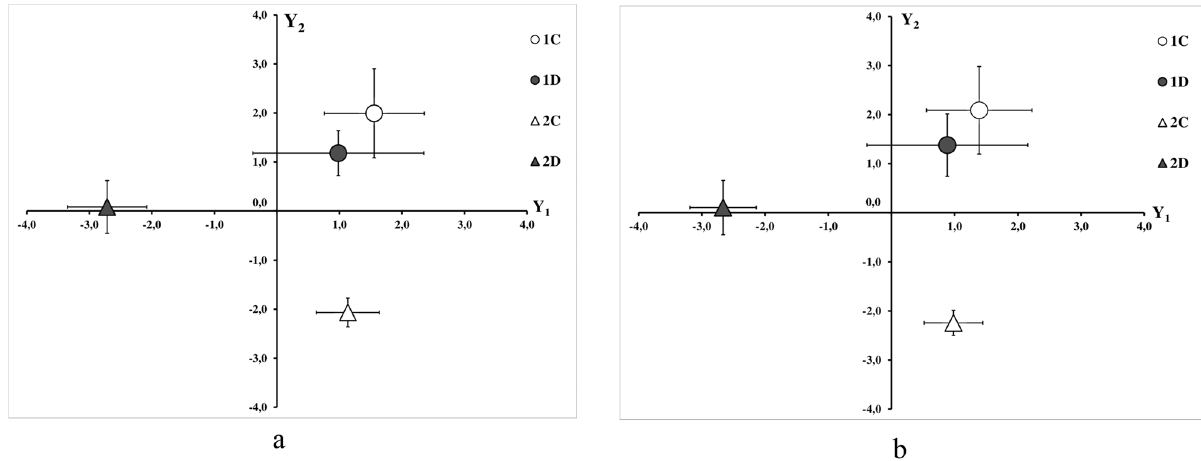
Figure 4. PLS-DA results: ( a ) steady calculation, ( b ) transient calculation. Groups of animals: 1, 2—the duration of the experiment in months, ( c )—control, ( d )—diabetes. Values are presented as mean ±